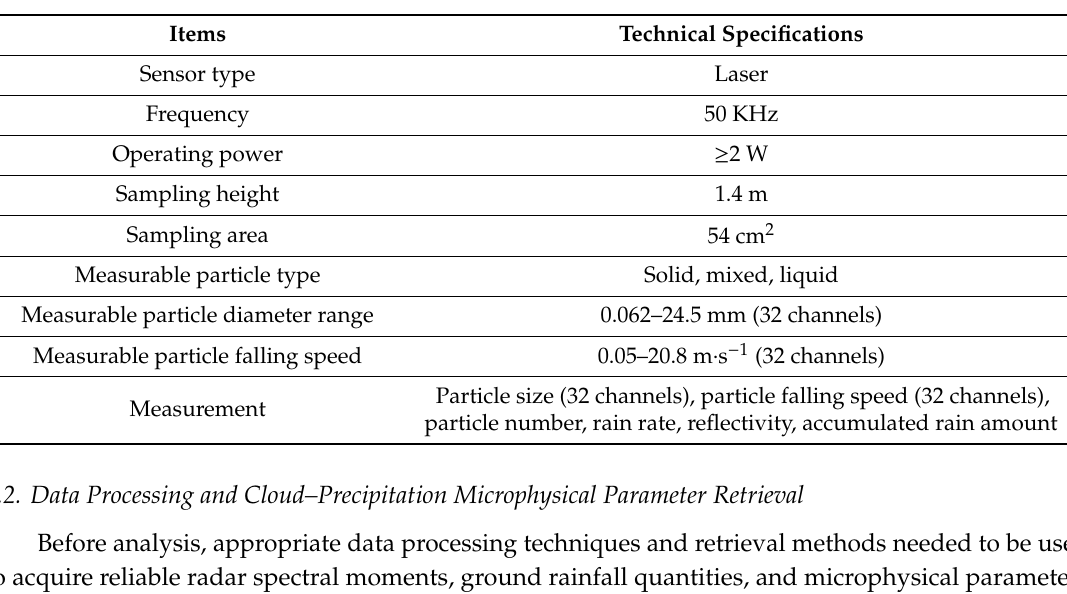
Table 2. The OTT particle size velocity (Parsivel) disdrometer main technical specifications.